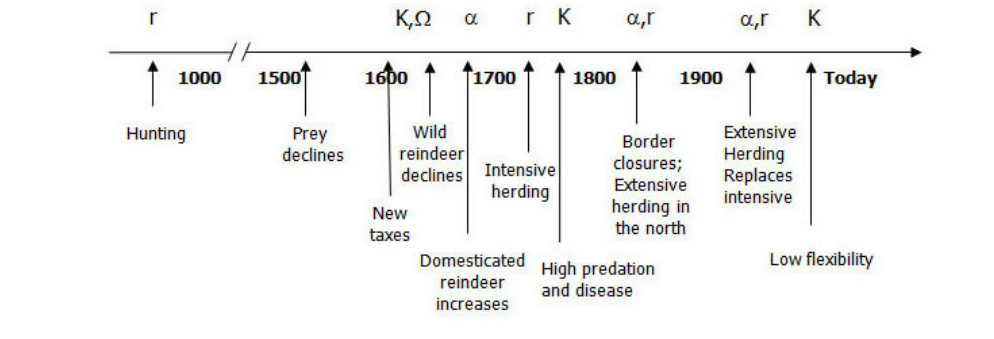
Fig. 3 . Examples of adaptive cycles in Swedish reindeer husbandry. The symbols above the timeline refer to the different phases of the adaptive cycle: the growth or exploitation phase (the r phase), the conservation or consolidation phase (the K phase), the collapse or release phase (the W phase), and the reorganization phase (the a phase). The data is adapted from Danell (2004, Fjällen i Fokus Conference, Umeå University, Sweden, unpublished data ) and from the references in this